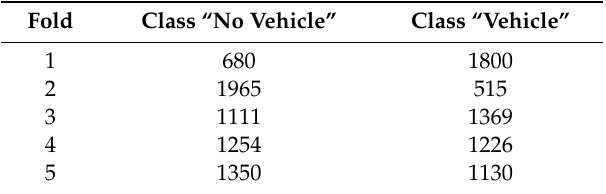
Table 5. Distribution of entries in “No vehicle” and “Vehicle”